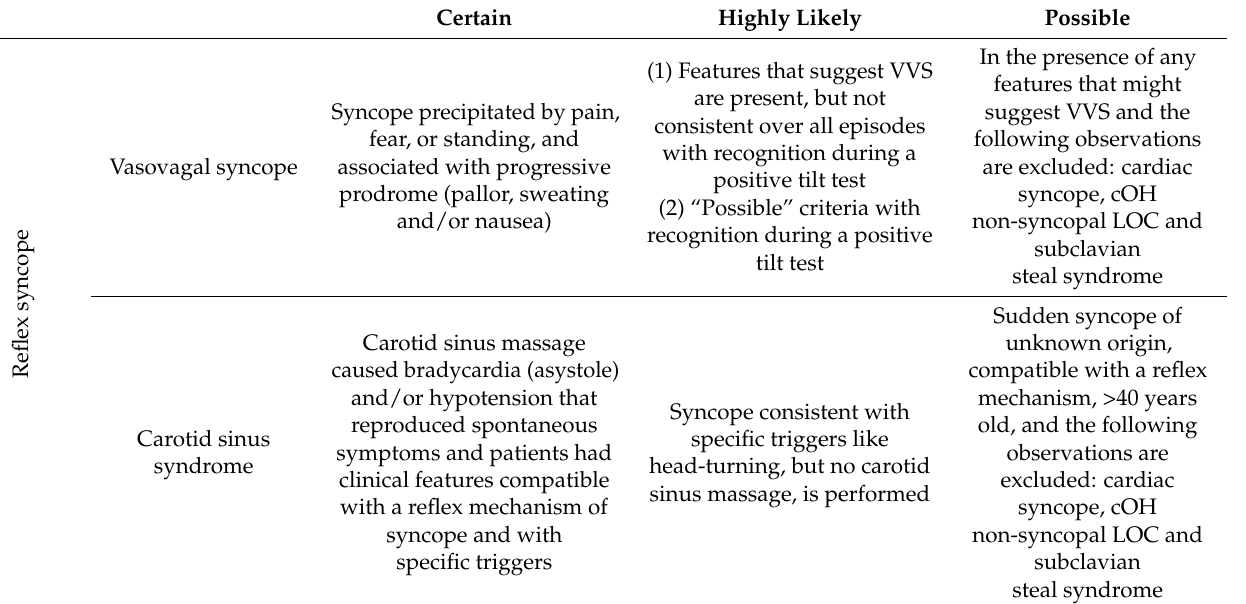
Table 1. Criteria applied for diagnosis with subjective probability level. Diagnostic criteria. This table is adapted from FAST II study (de Jong et al.